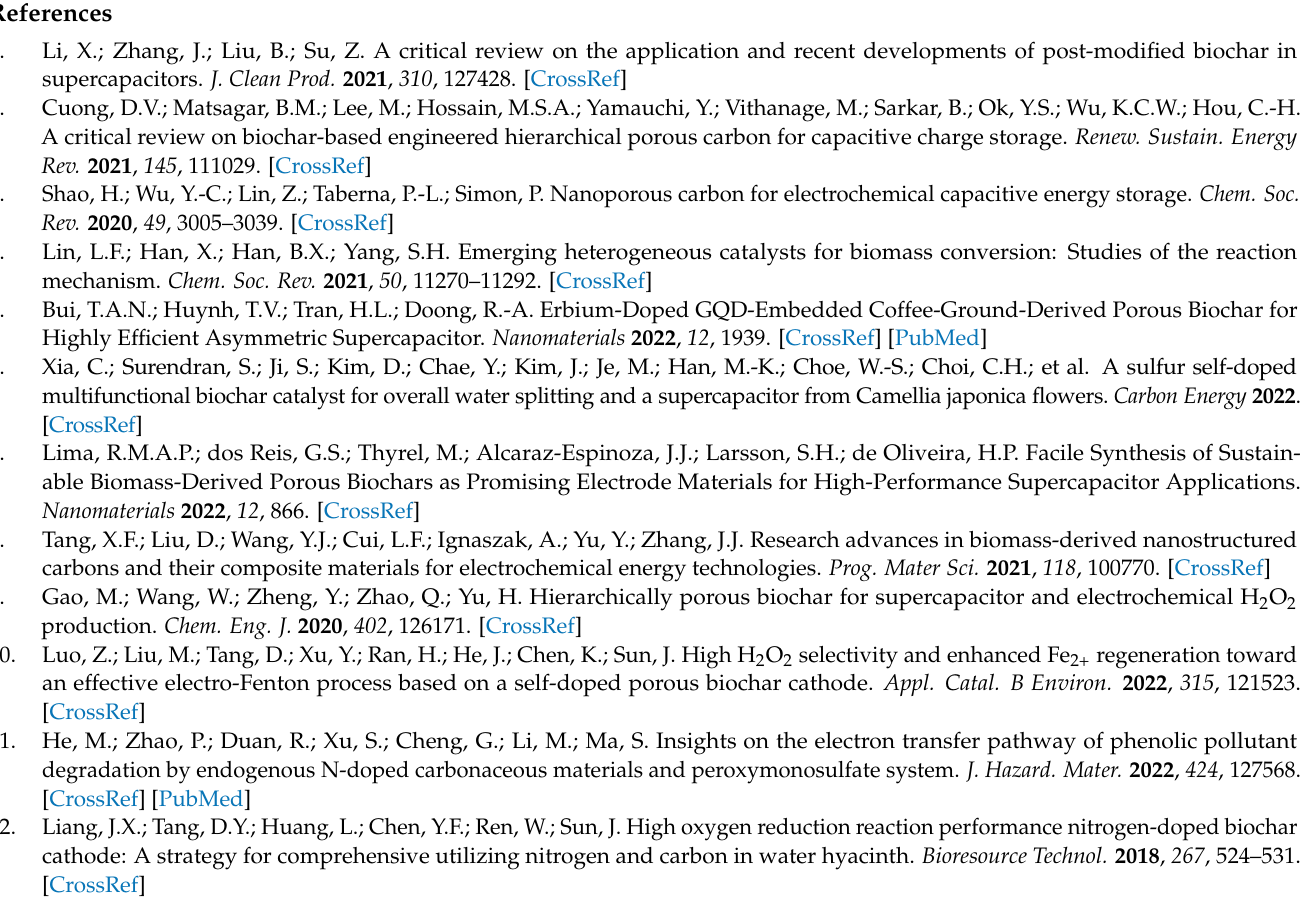
Figure S2: Experimental and simulated Nyquist plots for the indicated electrodes; Figure S3: Cycling experiments for phenol degradation by the BC-24/PDS system; Table S1: The resistance parameters deduced from the equivalent circuits of EIS measurements; Table S2: Comparison of the capacitive performance of BC-24 in a three-electrode system with other biochar materials in the